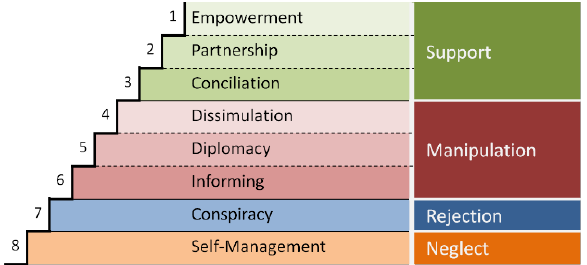
Figure 2 : Arnstein ’s Ladder of Community Participation, Choguill,